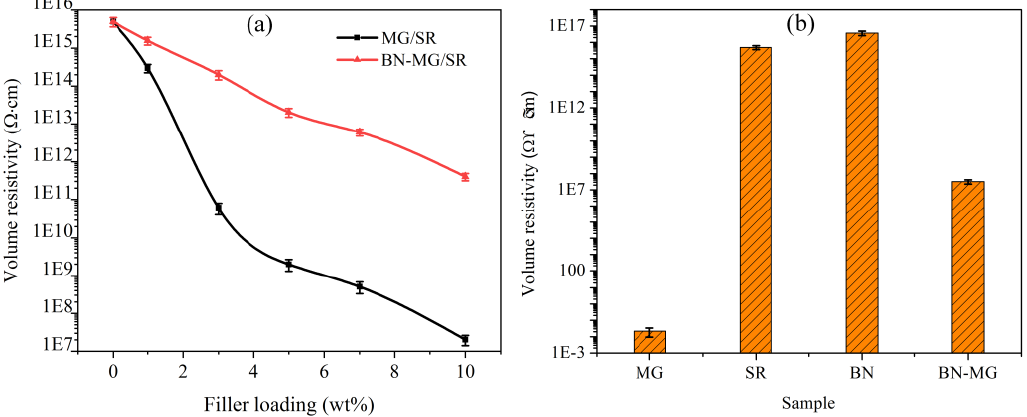
Figure 11. Volume resistivity of MG/SR and BN − MG/SR with different filler loadings ( a ) and volume resistivity of the fillers ( b ). Table 1. Comparison of thermal conductivity (TC) and volume resistivity (VR) of the BN − MG/SR composite in this work with those of other SR − based composites.